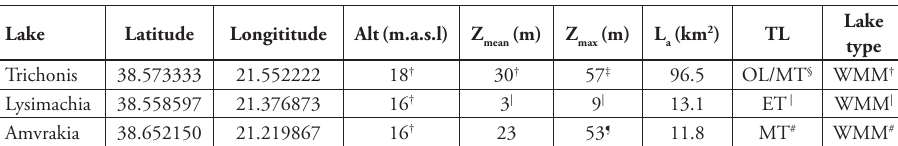
Table 1. Geographical position, morphological and limnological features of the studied lakes. Alt: al- titude; Z : mean depth; Z : max depth; L : lake surface area; TL: trophic level, ET: eutrophic, MT: mean max a mesotrophic, OL: oligotrophic; WMM: warm